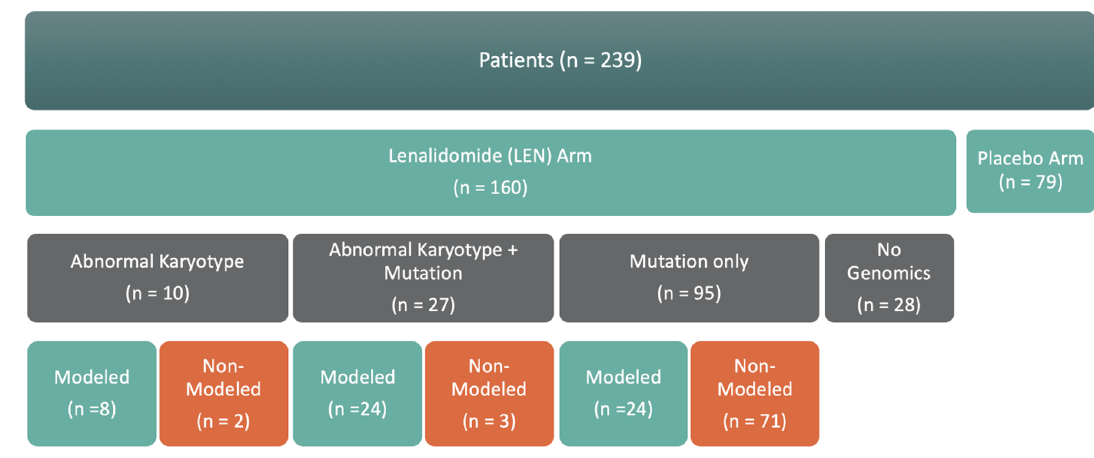
Figure 2. Summary of Genomic Information Sufficiency for Computational Modeling.